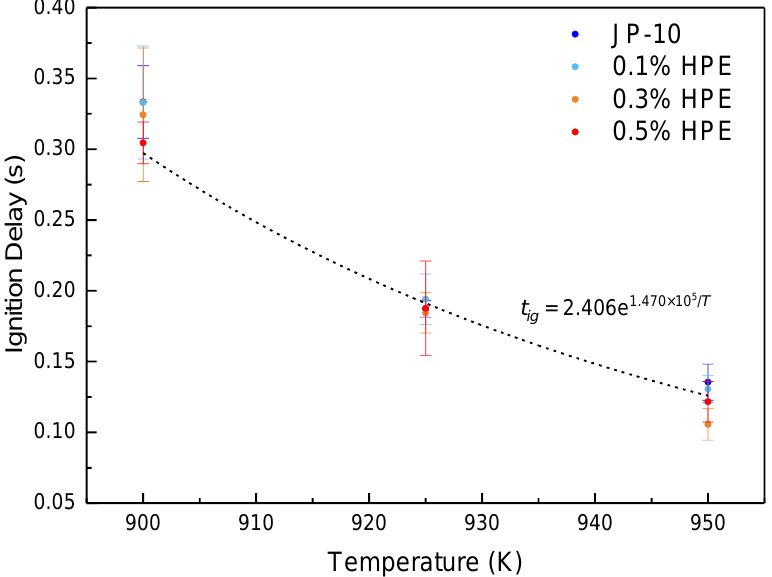
Figure 10. Variation in ignition delay with HPE concentrations at temperatures of 900–950 K. Error bars show the standard deviation.